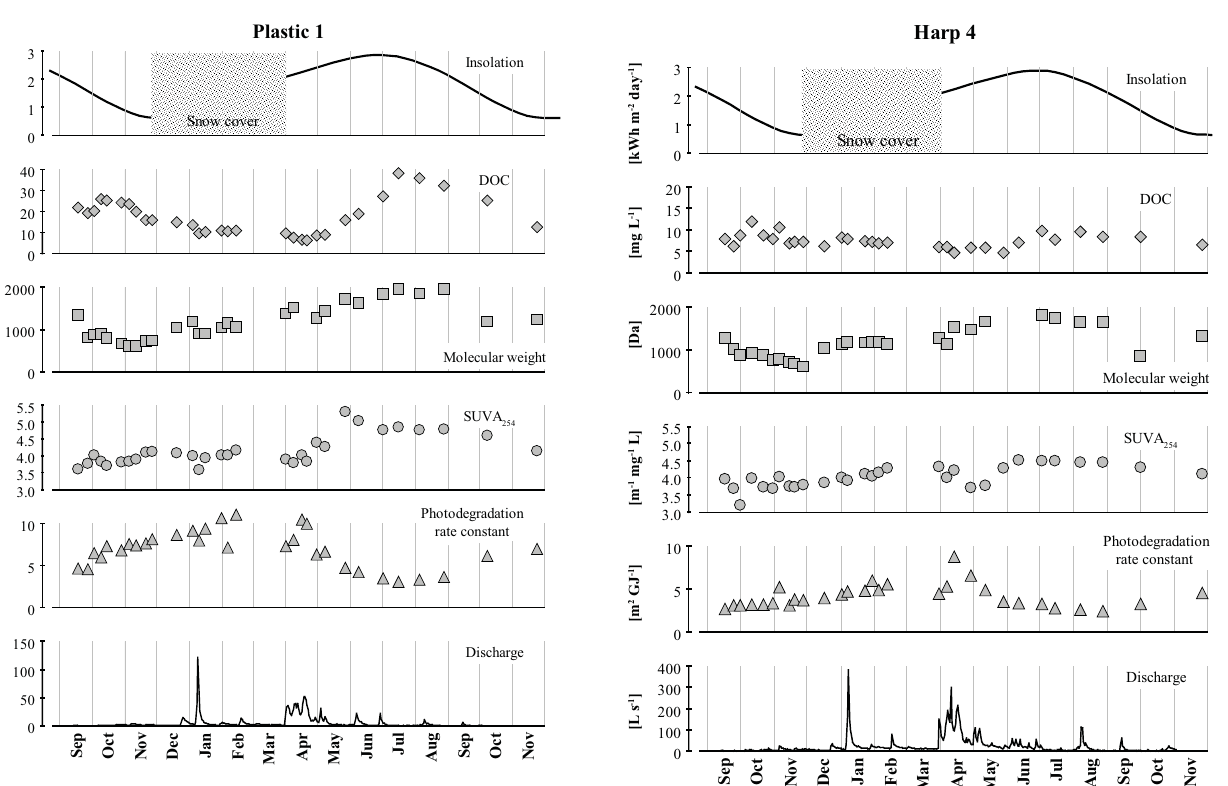
Fig. 4. Harp 4 (HP4) tributary to Harp Lake. Average incident in- solation, DOC, apparent molecular weight, SUVA 254 , photodegra- dation rate constant and mean daily discharge during hydrological year